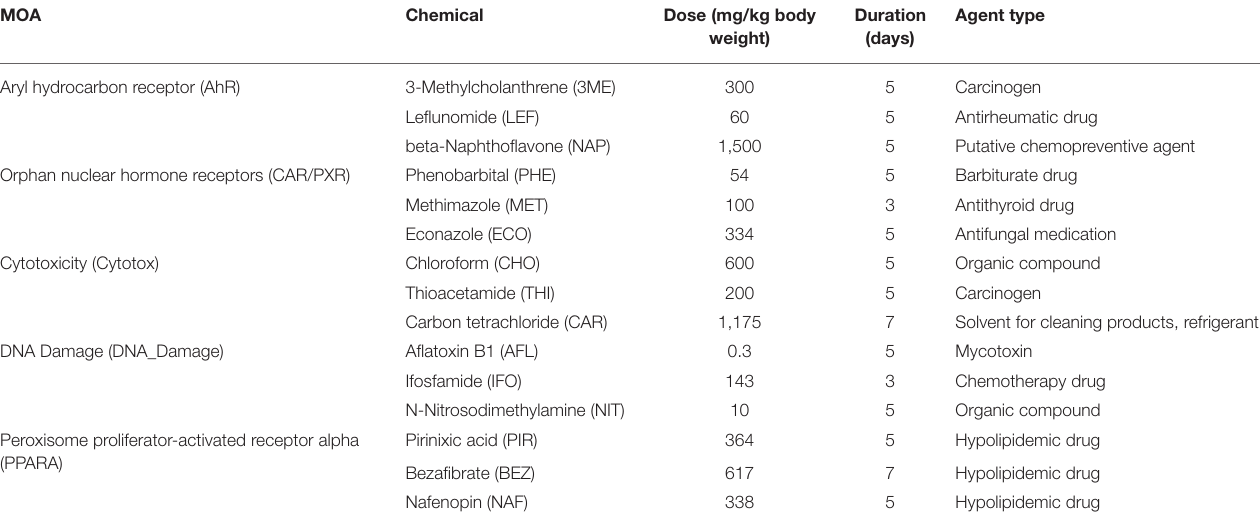
Duration weight) (days)